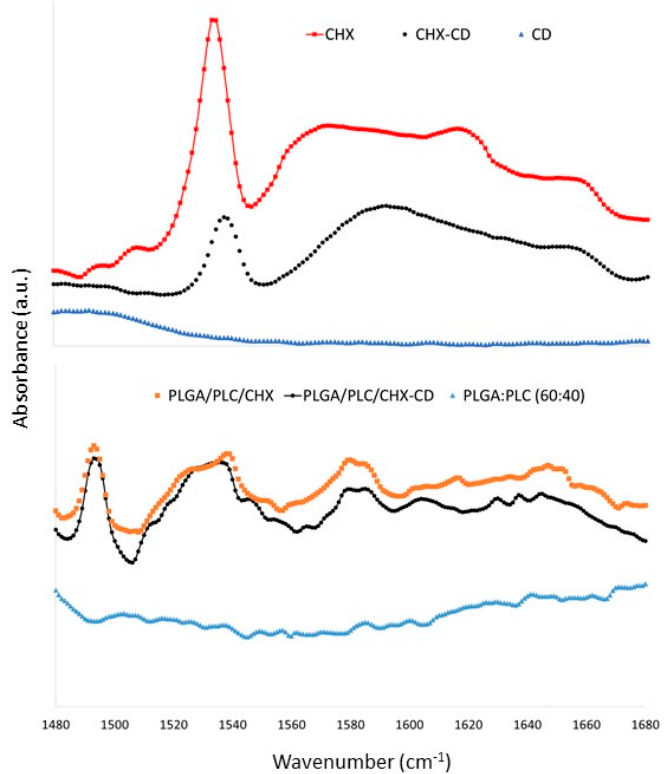
Figure 1. Fourier-transform infrared spectroscopy (FTIR) spectrum of the CHX, CD, the complex CHX-CD, the membrane PLGA / PLC: (60:40), the membrane PLGA / PLC / CHX (60:40:4) and the membrane PLGA / PLC / CHX-CD (60:40:4).